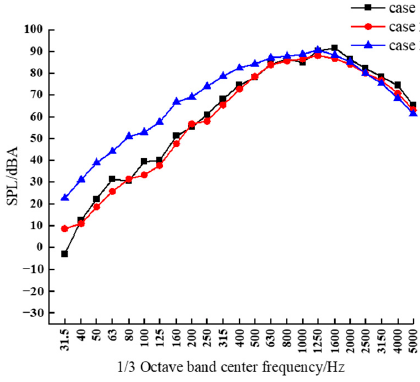
Figure 13. The 1/3 octave band frequency spectra of aerodynamic noise at the standard observer points of maximum sound pressure level (case 1: 6th monitoring point; case 2: 6th monitoring point; case 3: 4th monitoring point).